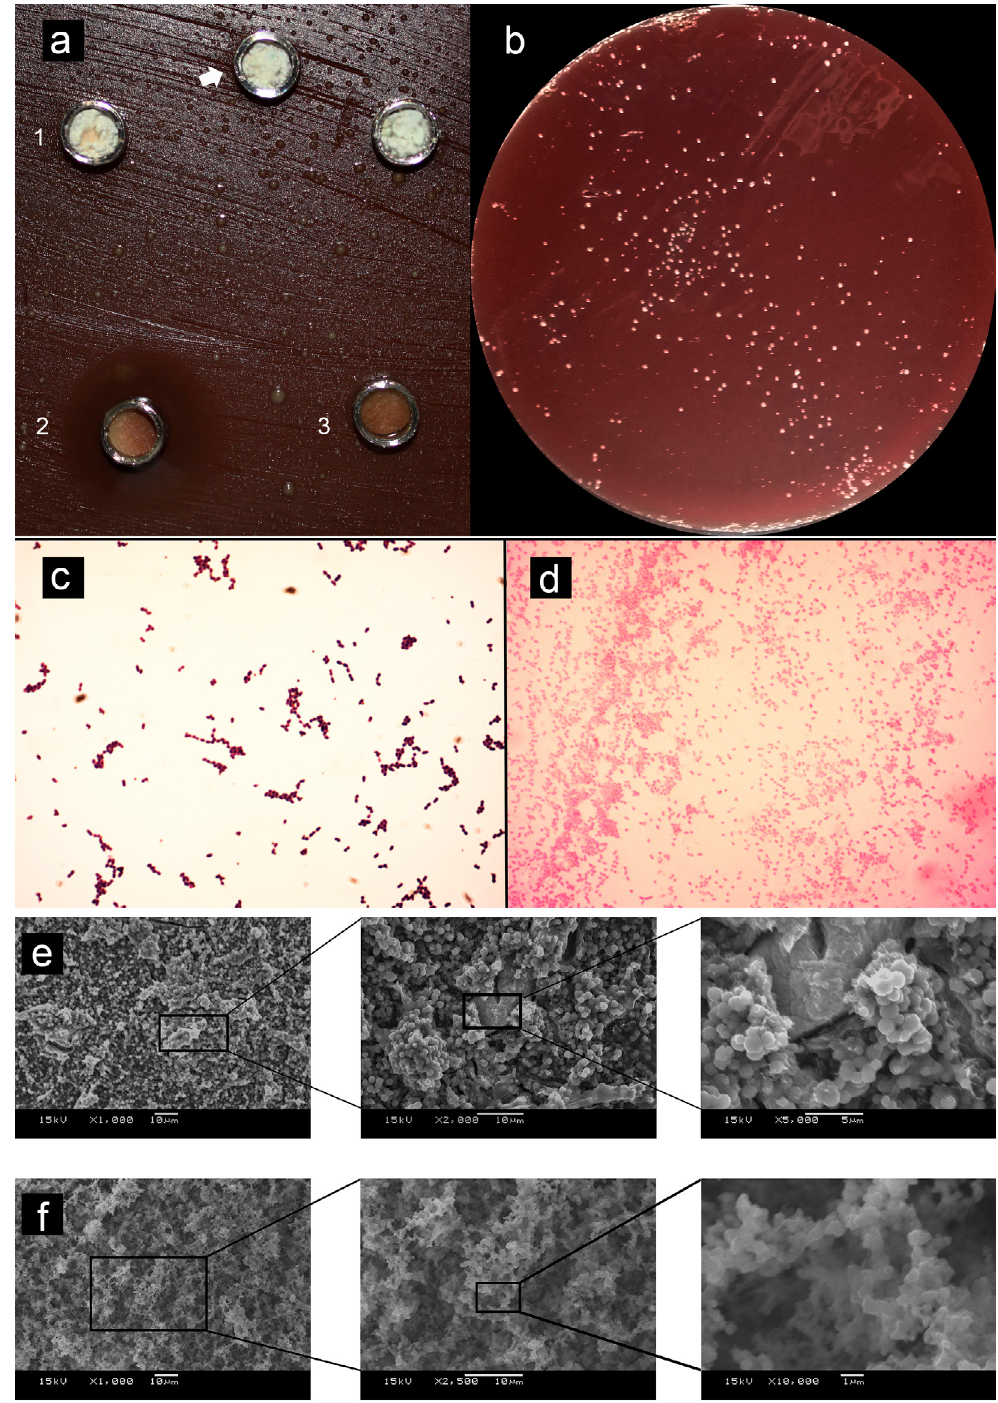
Figure 4- (a) - 1) Grey-MTAFlow cement without inhibition halos in BHI medium containing inoculated E. faecalis; (2) Chlorhexidine gel used as a control for antimicrobial activity presenting inhibition halo; (3) Additional metallic disc containing only silicon-based gel without inhibition halo as well; the arrow is indicating the collection area for smear and viability tests. (b) Viability test for E. faecalis after 7 days showing viable bacteria adjacent to the disc. (c) The smear of E. faecalis after 7 days in contact with fresh Grey-MTAFlow cement. (d) The smear of P. gingivalis after 5 days in contact with fresh Grey-MTAFlow cement. (e) Representative SEM images of the surface of Grey-MTAFlow in contact with E. faecalis at 1,000x, 2,000x, and 5,000x magnifications. (f) Representative SEM images of the surface of Grey-MTAFlow in contact with P. gingivalis at 1,000x, 2,500x, and 10,000x